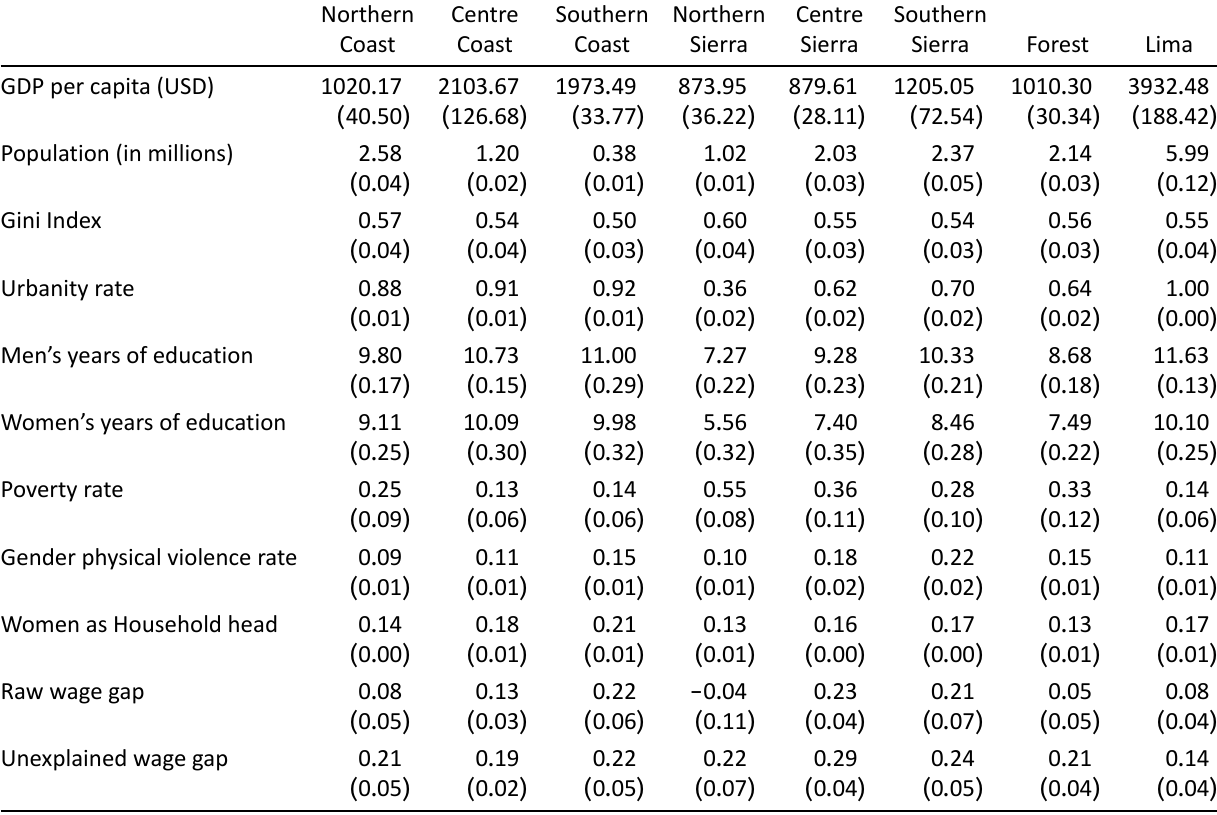
Table 7. Summary statistics by